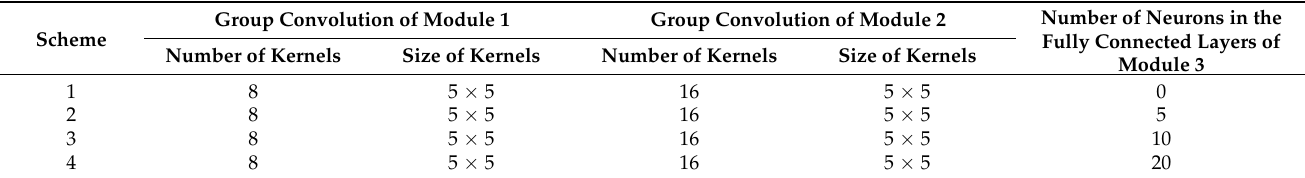
Table 6. Hyperparameter combination schemes with different numbers of neurons in the fully connected layer 1 .